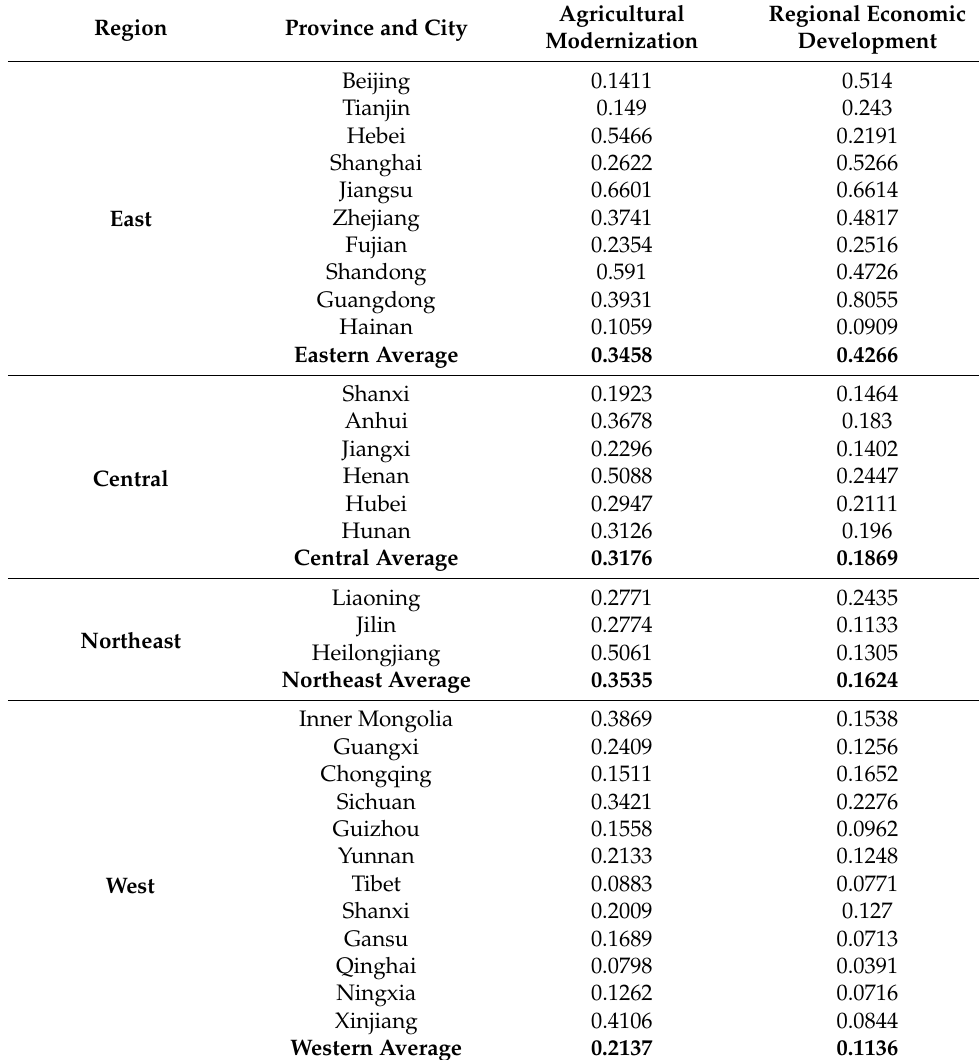
Table 4. The average value of the comprehensive evaluation index of agricultural modernization and regional economic development of each province and city in China from 2011 to